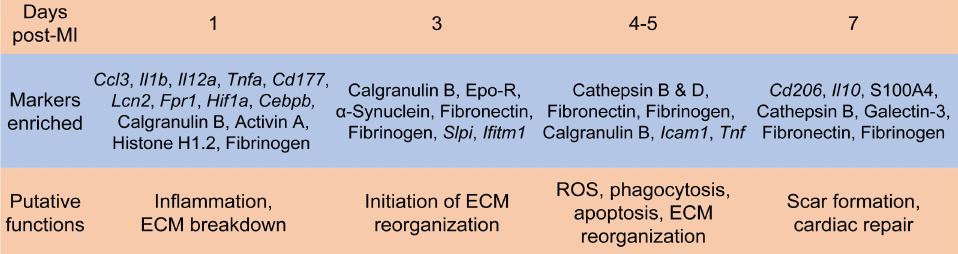
Figure 2. Neutrophils in the infarcted myocardium at different time points post-MI exhibit distinct phenotypes and